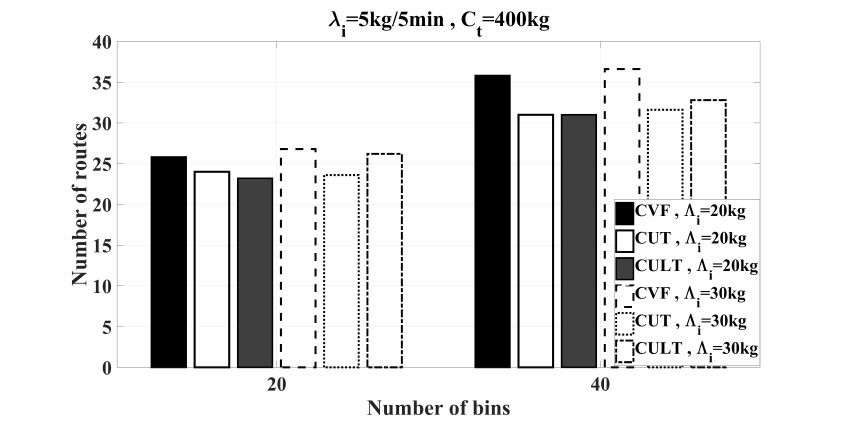
Figure 17. Number of routes: bin count when the truck capacity was increased.